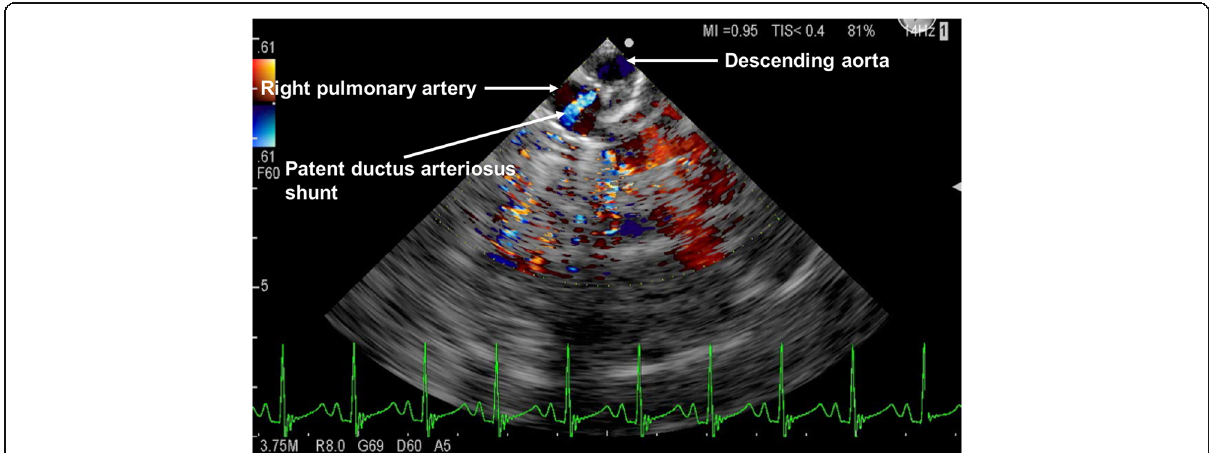
Fig. 1 Residual PDA shunt flow on color Doppler flow imaging . A mosaic jet moving from the descending aorta toward the pulmonary artery, indicating a residual PDA shunt, is